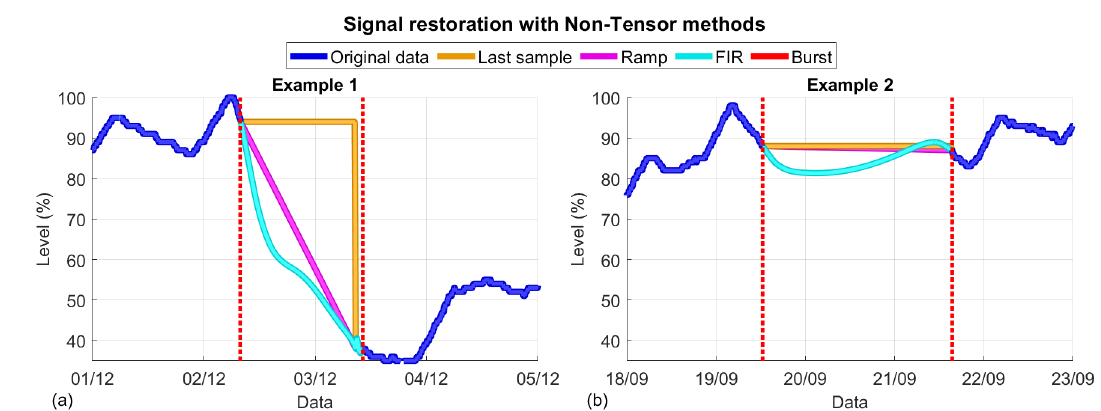
Figure 3. Particular cases of signal restoration using non-tensor methods: ( a ) Shows a middle-length burst where the last sample method does not work effectively but the ramp and FIR (Finite Impulse Response) methods do; ( b ) shows a large-length burst where only the FIR method gives a coherent